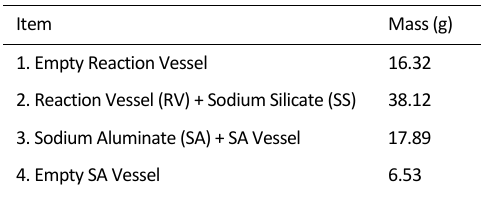
Table 1. Mass of stock solutions and vessels used to synthesize